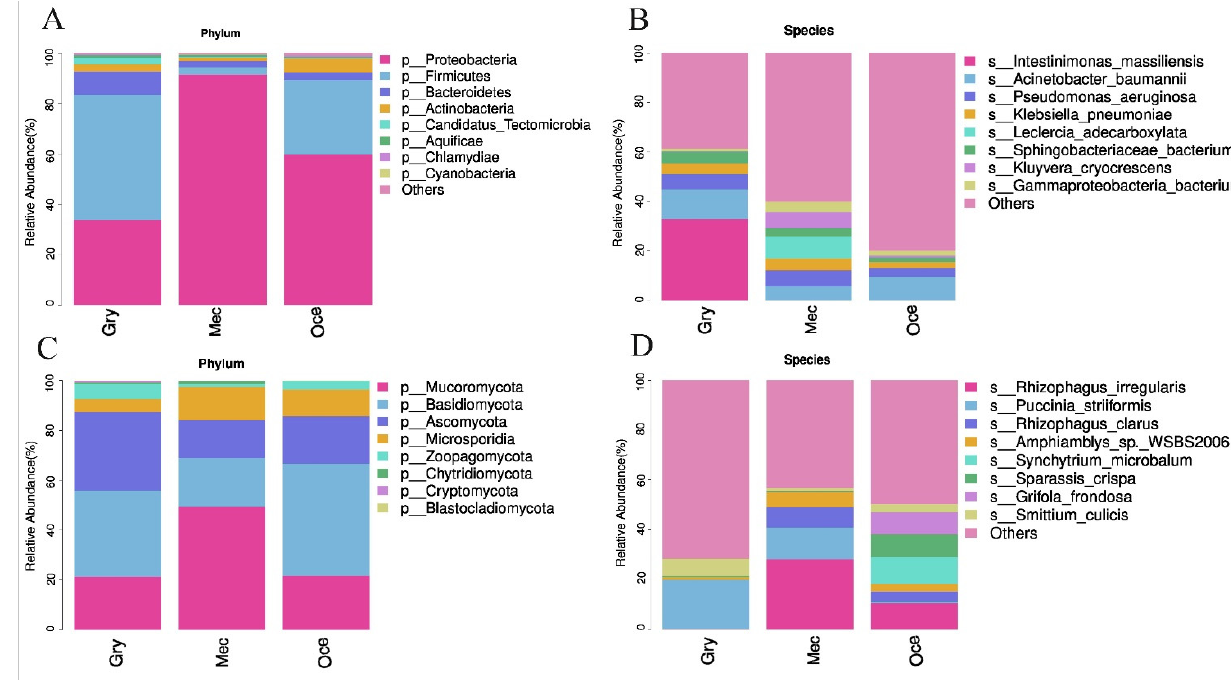
Figure 2. A stacked bar chart revealing the relative abundance of gut bacterial and eukaryotic composition at the ( A , C ) phylum and ( B , D ) species levels. The results show the phylum and species of the gut microbiota with the highest abundance.